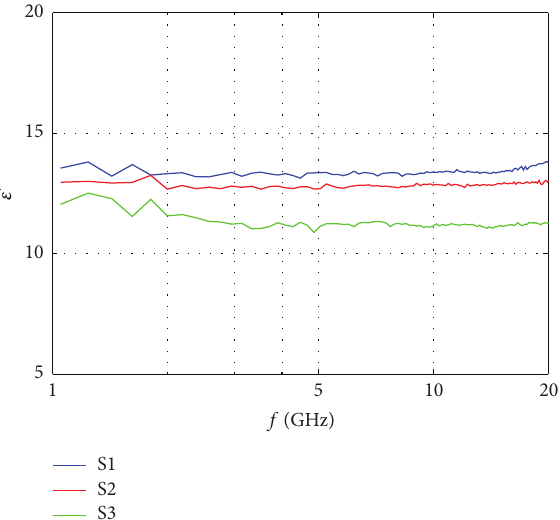
Figure 5: Spectra of real part of permittivity of the sintered ferrite